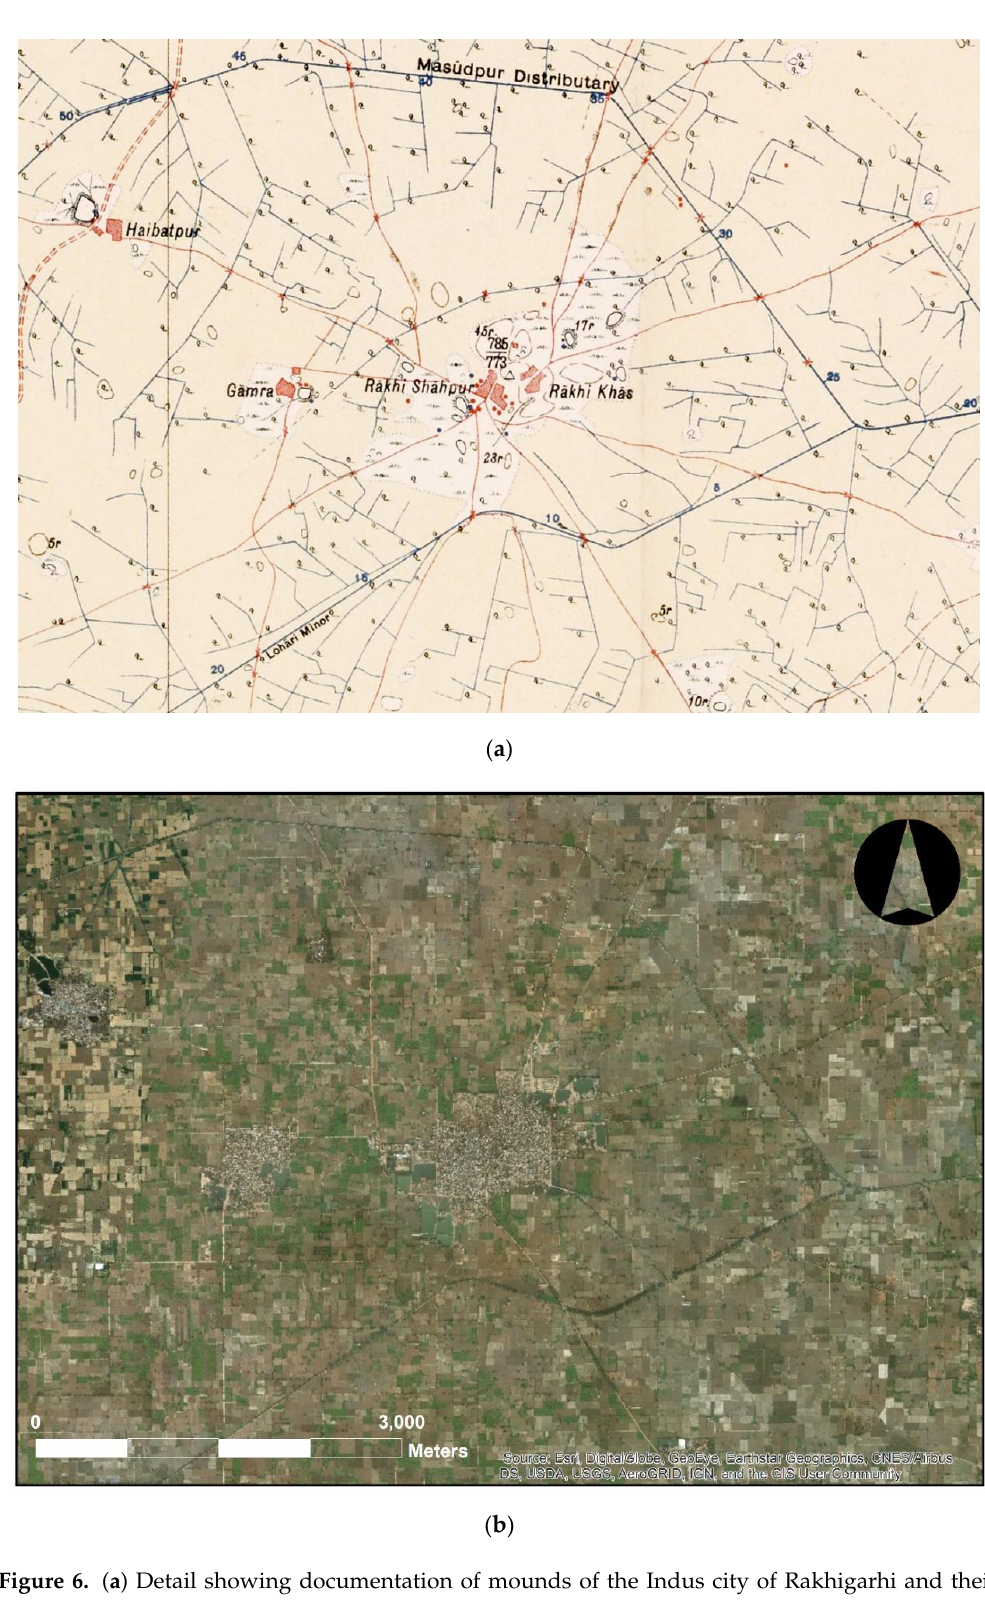
Figure 6. ( a ) Detail showing documentation of mounds of the Indus city of Rakhigarhi and their relationship to the modern towns of Rakhi Shapur and Rakhi Khas (53/C3/1915) (Image courtesy of Cambridge University Library); ( b ) ESRI world imagery of the same region today.